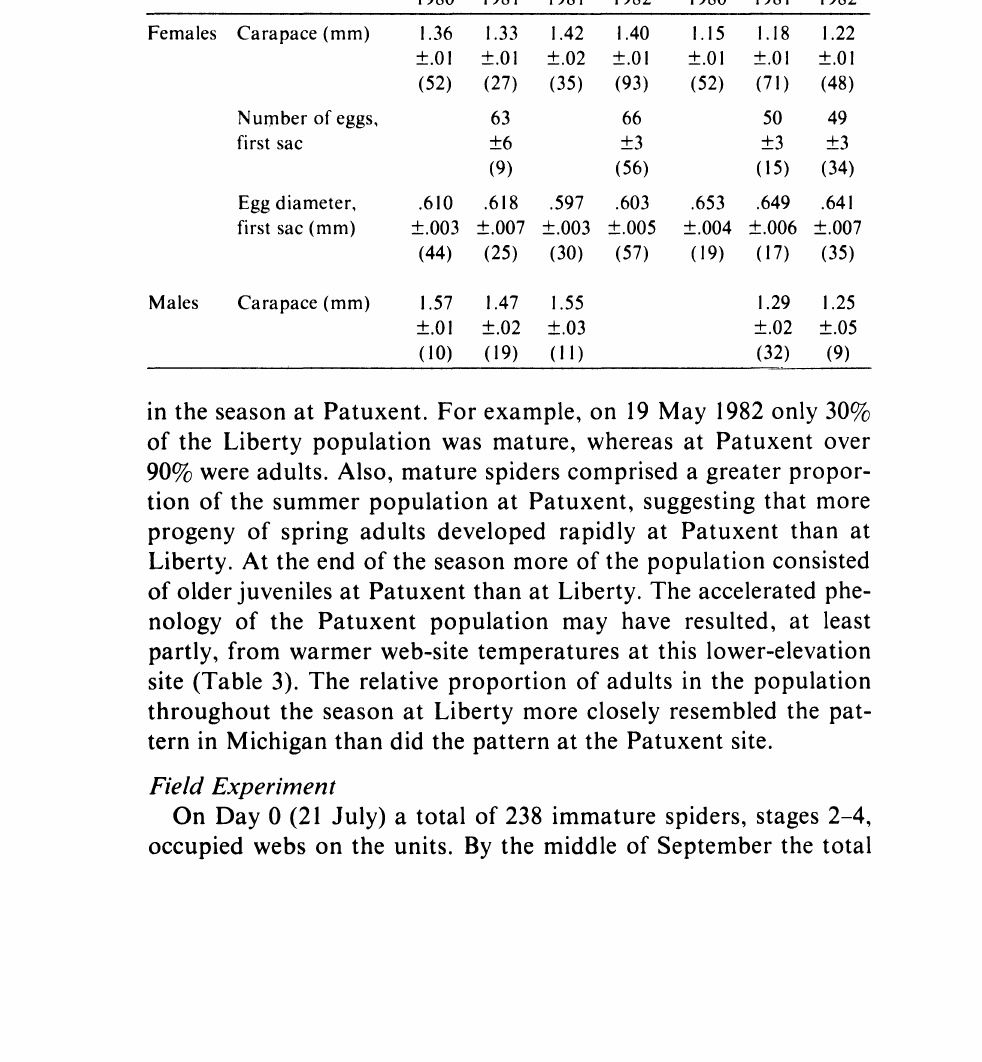
Table 1. Differences between spring and summer in size at maturity and repro- ductive parameters of spiders from Patuxent and Liberty populations. Means _+ s.e. are given with sample sizes in parentheses. The Bonferroni Multiple Comparison Test was used to examine the significance of seasonal differences for the Liberty population in 1980, and for Patuxent in 1981 and 1982. Differences between spring and summer in carapace width, egg number and egg size were all significant at p < .01 or greater. Means did not differ significantly between areas within the same season and year. Means also did not differ significantly between years, with the exception of male carapace width in the Liberty population between the springs of 1980 and 1981 (p < .01).